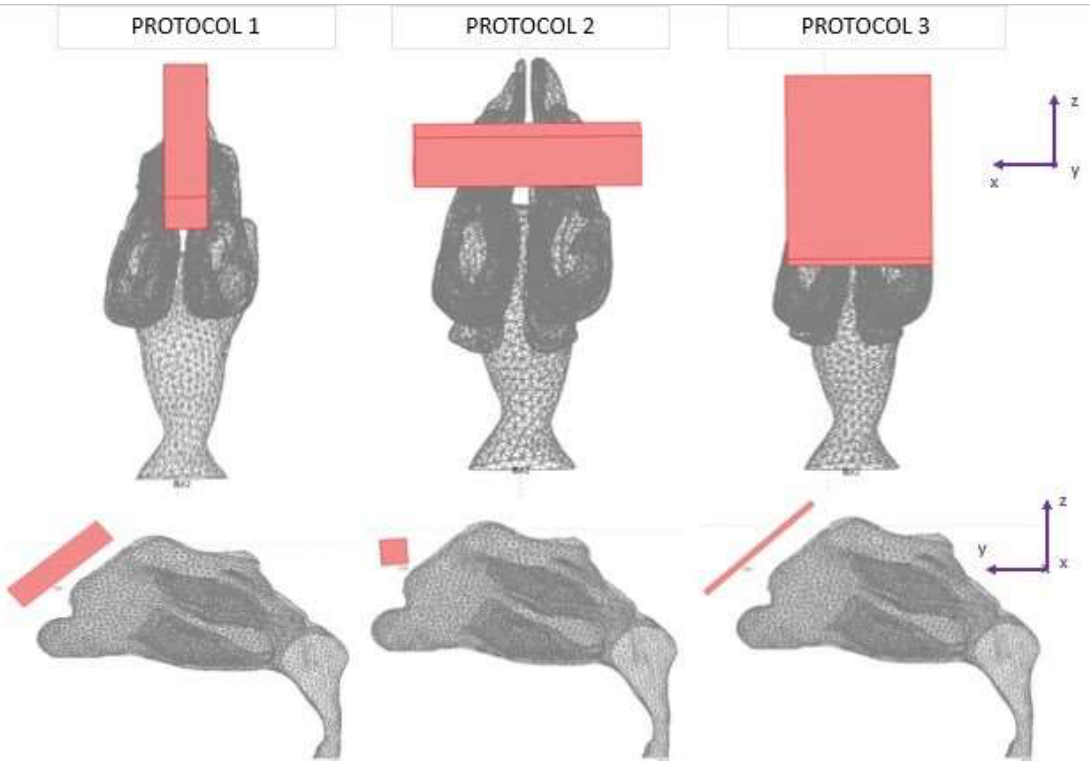
Figure 3. The three studied magnets’ layouts, referred to as ‘protocols’, depicted in two different reference planes. The red object denotes the magnet’s position in each layout.